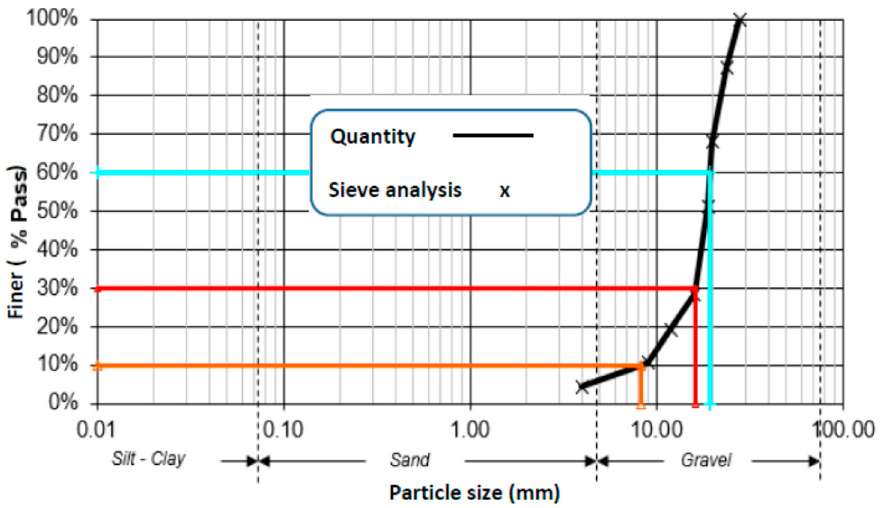
Figure 1. Gradation of gravel size for the concrete mixture .